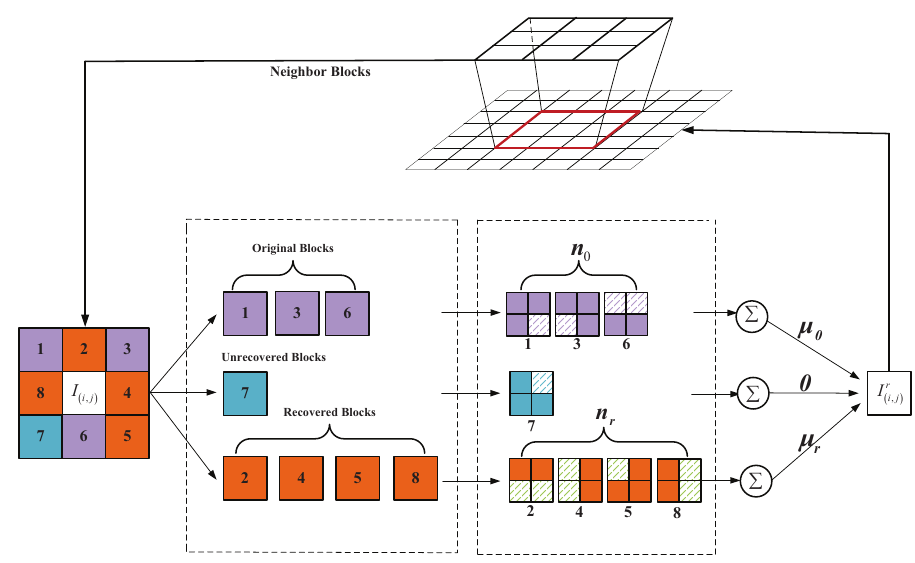
Figure 10. Level-2 recovery